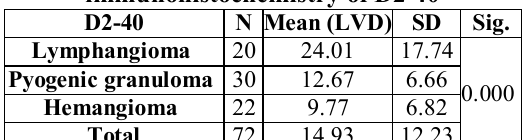
Table 1: Description of statistics obtained by